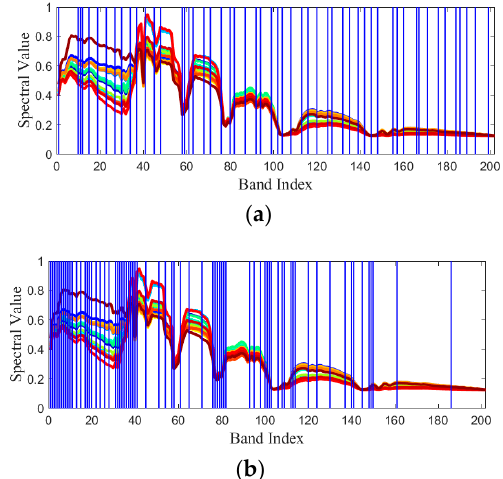
Figure 11. The BG results for the Purdue experiment. ( a ) FNG; ( b ) BD.